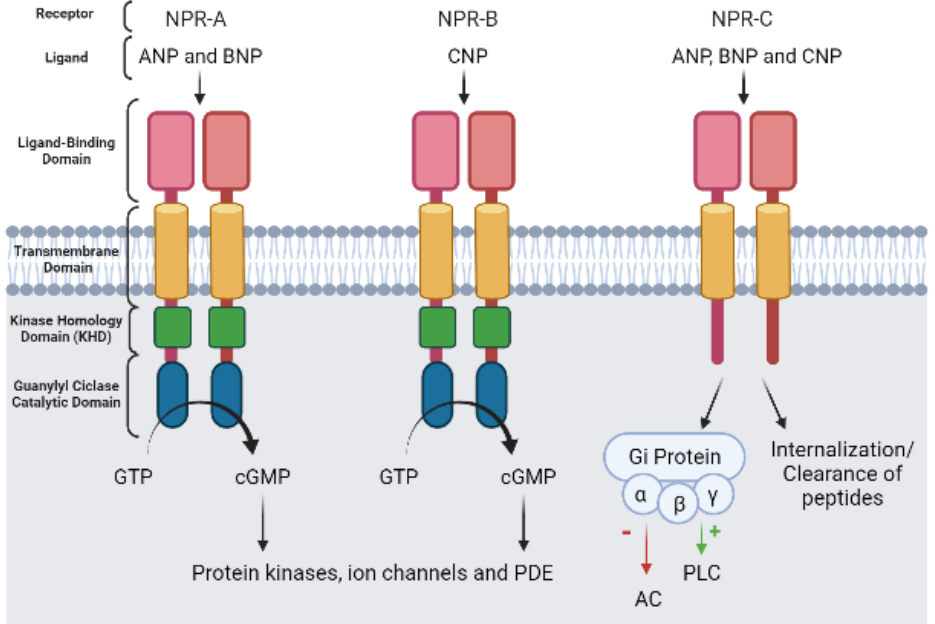
Figure 2. Structure of the natriuretic peptide receptors (NPR) (created with biorender.com). The NPR type A (NPR-A) and NPR type B (NPR-B) receptors have a similar structure, which consists of the extracellular N-terminal domain, the transmembrane domain, the kinase homology domain (KHD), the domain responsible for dimerization, and the GC catalytic domain, which contains the C-terminal region. The NPR type C (NPR-C) receptor has extracellular N-terminal and transmembrane domains but lacks the GC catalytic